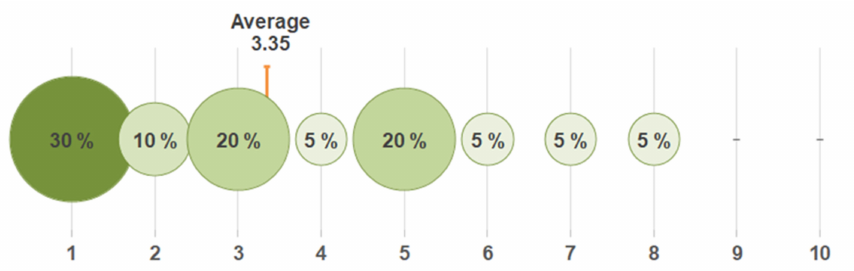
Figure 8. Distribution of the answers concerning the potential of static and dynamic charging (1 = static and 10 = dynamic).